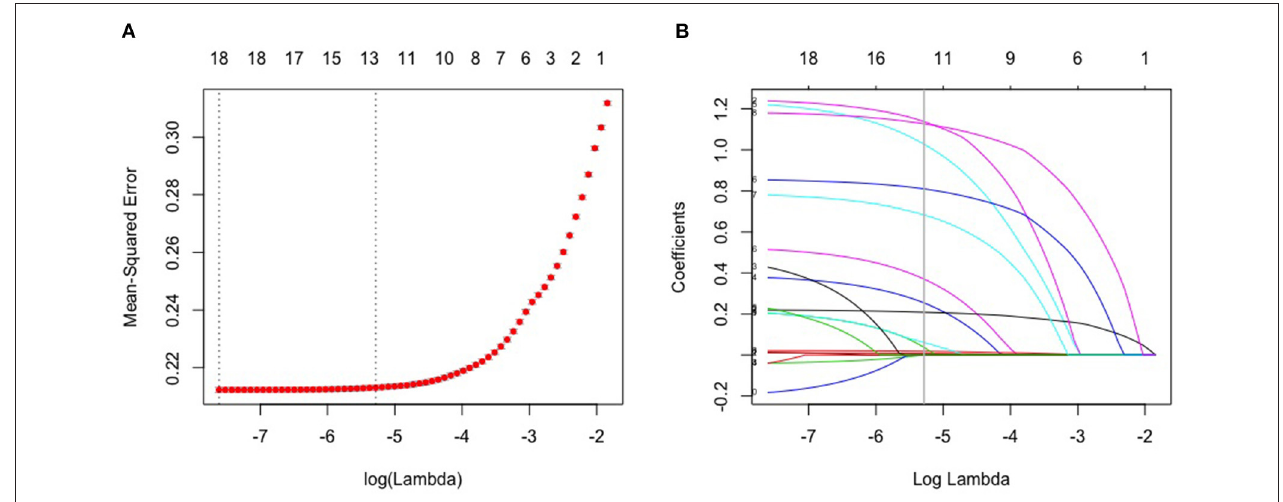
FIGURE 2 | Lasso algorithm for feature selection. (A) mean-squared error (10-fold cross-validation criterion) of LASSO penalized logistic regression algorithm. (B) Vertical line was drawn at the value selected using 10 times cross-validation, where optimal lambda resulted in 12 features with nonzero coefficients.